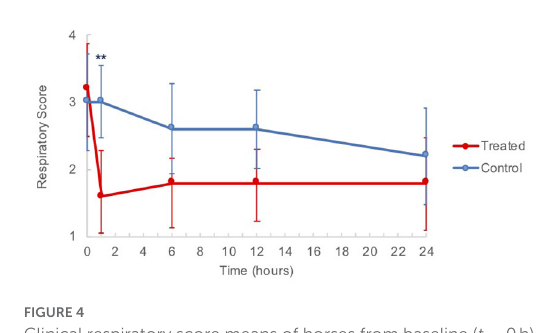
FIGURE4 Clinical respiratory score means of horses from baseline ( t = 0h) to 24h post nebulization with either control substance or G-CAPE (treated). ** p = 0.0013.